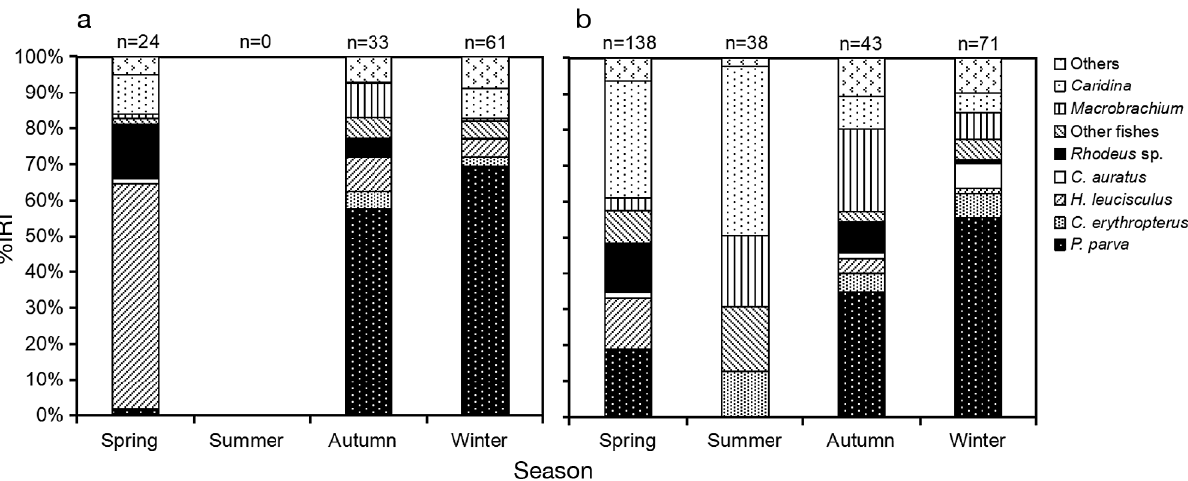
Fig. 5. Diet composition of (a) hatchery-reared mandarin fish and (b) wild mandarin fish in different seasons in Xiaosihai Lake, based on the index of relative importance (%IRI) of major prey groups from stomach content analysis. Sample sizes are above bars